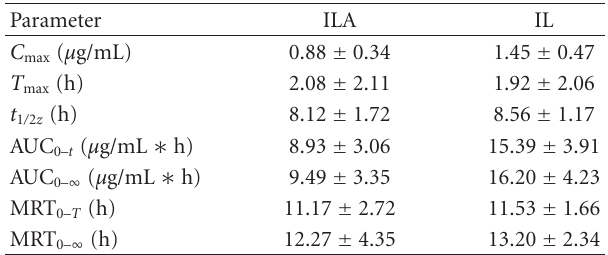
matrix [19]. Acetonitrile and methanol were tested as